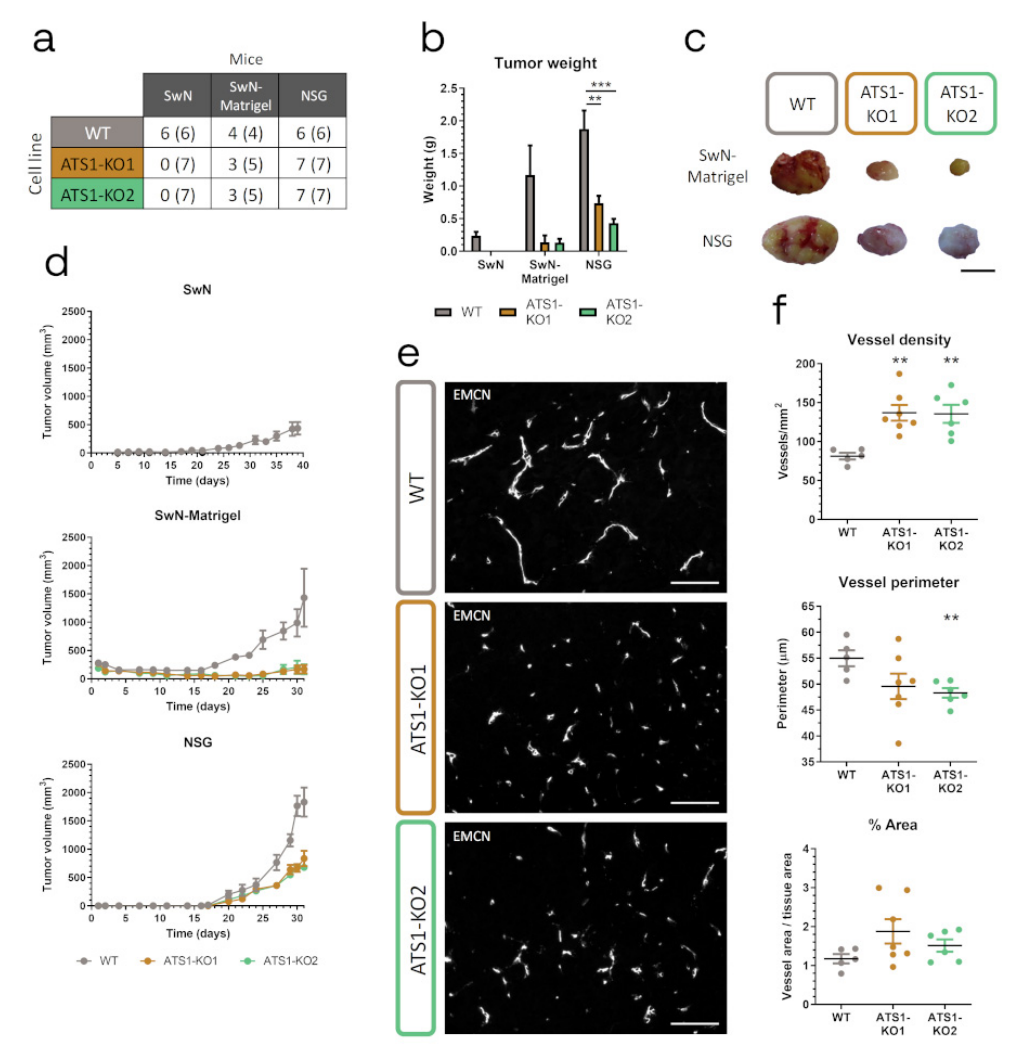
Figure 3. ADAMTS1 inhibition blocks tumorigenesis and alters tumor vasculature. ( a ) Table indicating the number of mice that developed tumors and the total number of injected mice of every experimental group (in parenthesis); ( b ) Graph representing final tumor weight of di ff erent experimental groups, according to panel A; ( c ) Representative pictures of tumors from SwN-Matrigel and NSG groups (black scale bar = 1 cm); ( d ) Graphs representing tumor evolution for each experimental group. ( e ) Representative images of EMCN immunofluorescence analysis of tumor sections from WT and ATS1-KO NSG xenografts (white scale bar = 100 µ m); ( f ) Graphs representing tumor vasculature quantification of NSG xenografts: vessel density, vessel perimeter and percentage area ( n = 5 for WT; n = 7 for ATS1-KO1; n = 6 for ATS1-KO2). (***, p < 0.001 and **, p < 0.01. Tumors generated with WT cells were used as control for statistical